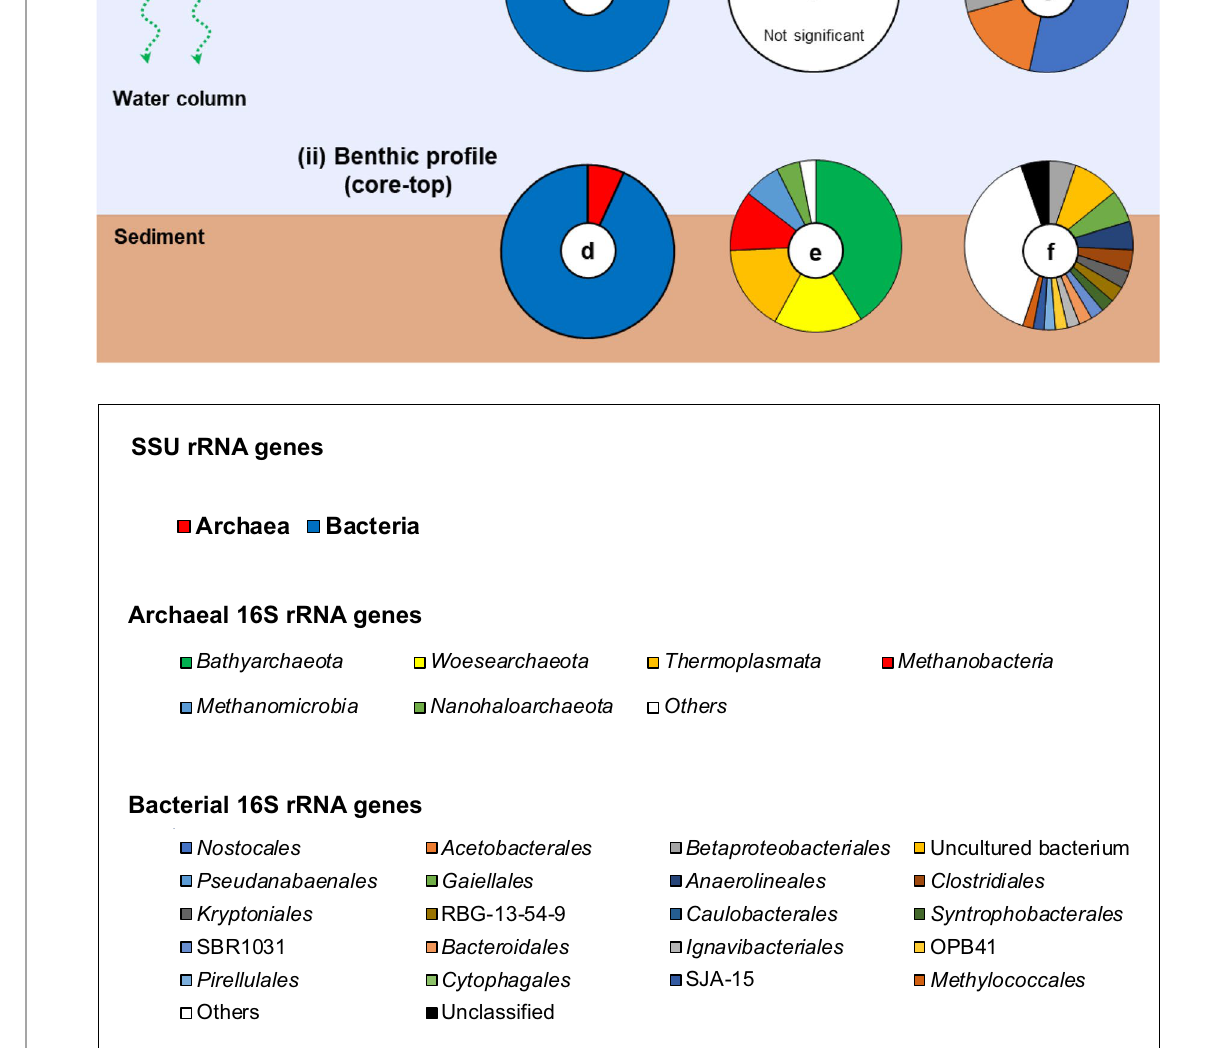
Fig. 6 Cross‑section of SSU rRNA gene tag sequencing analysis of the samples collected in September 2018. a , b , c Planktonic cyanobacterial sample. d , e , f Benthic sediment sample. Relative abundance of each domain ( a , d ), archaeal community ( b , e ), and bacterial community ( c , f ) based on the number of sequence reads obtained. Within archaeal sequences of the planktonic sample, two reads of the archaeal sequences were assigned to methanogenic archaea. They were affiliated with the hydrogenotrophic genus Methanoregula and hydrogen‑dependent methylotrophic family Methanomassiliicoccacea . Those two sequences were not found in the benthic